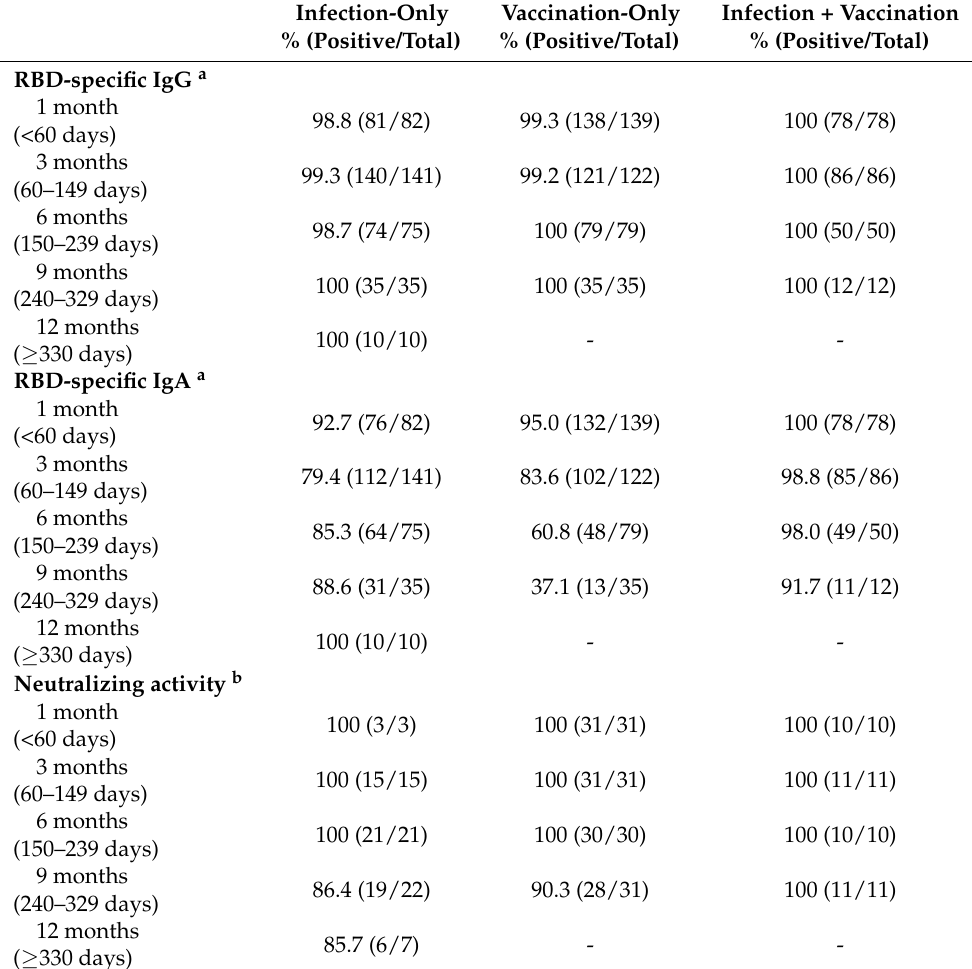
Table 2. Proportions of participants with positive antibody responses or neutralizing activity over total tested at each time point past infection or